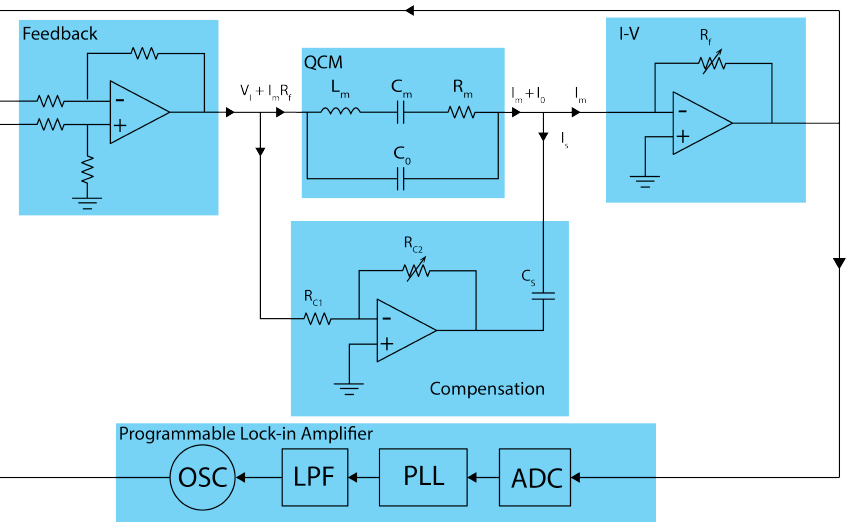
Figure 19. PLL circuit for series resonant tracking with manual C 0 compensation. Redrawn from [64] under the Creative Commons CC BY 4.0